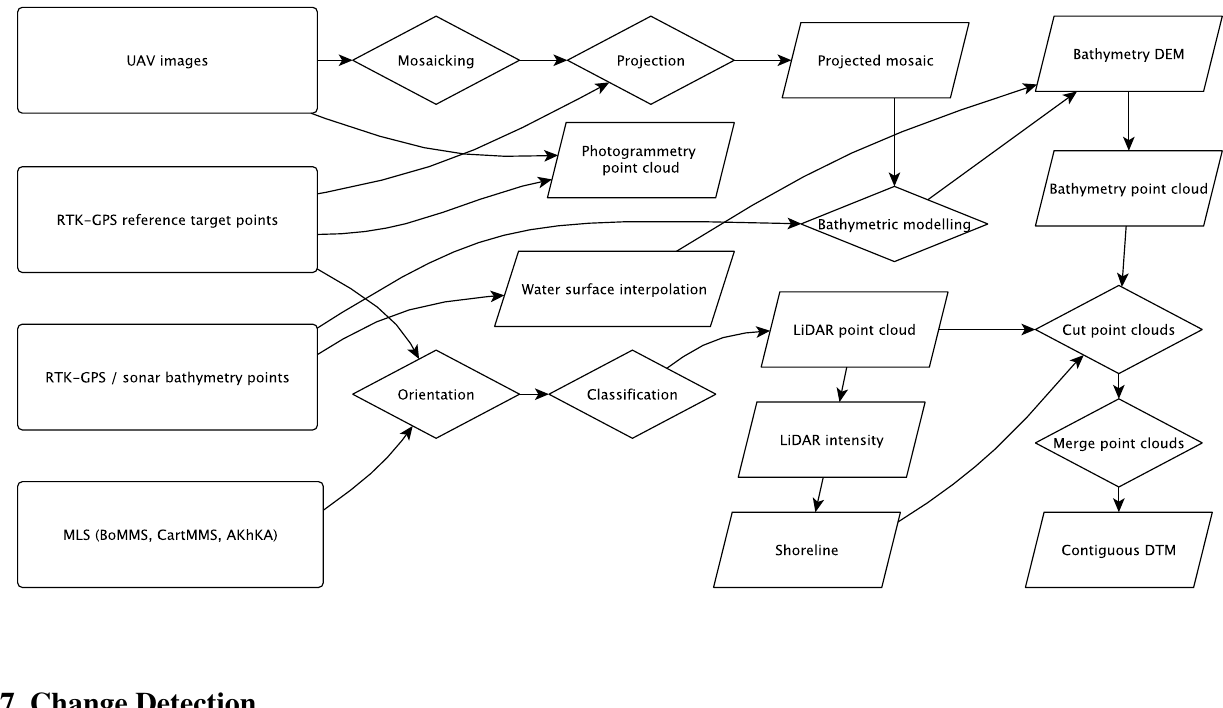
Figure 11. Flowchart illustrating the process of creating a contiguous DTM from LiDAR and UAV-photography